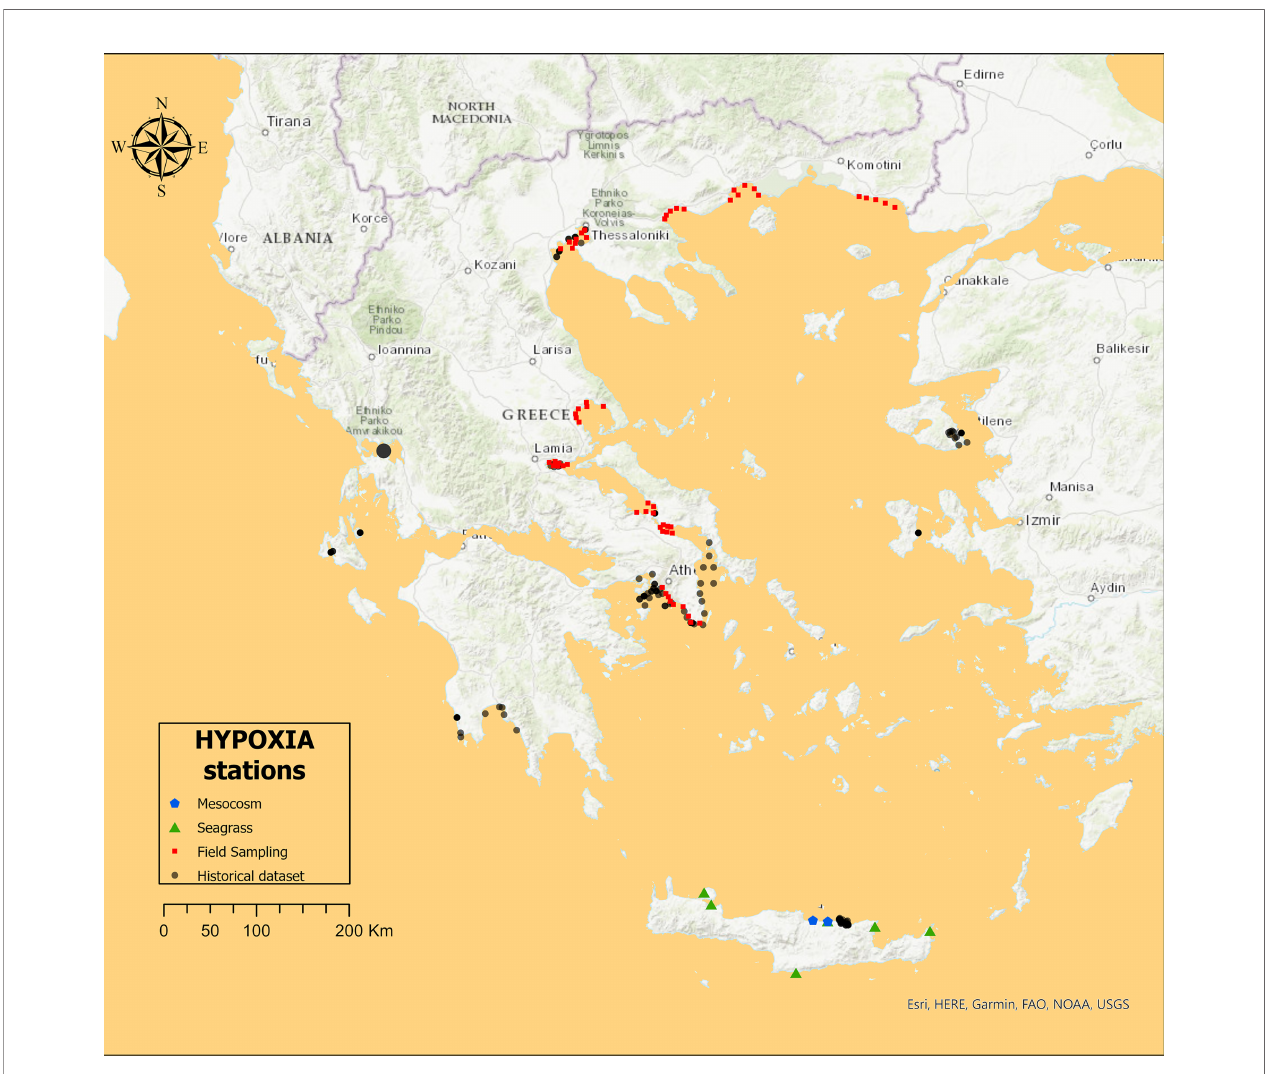
FIGURE 1 | The sampling stations included in the HYPOXIA project, in the Aegean Sea and the Ionian Sea of the east Mediterranean